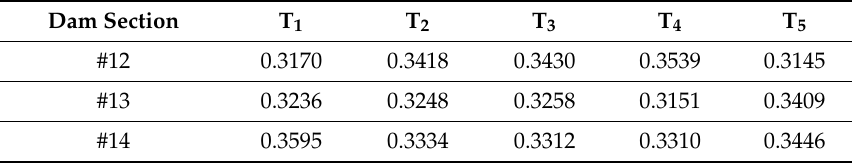
Table 11. The weights of all the dam sections at five time